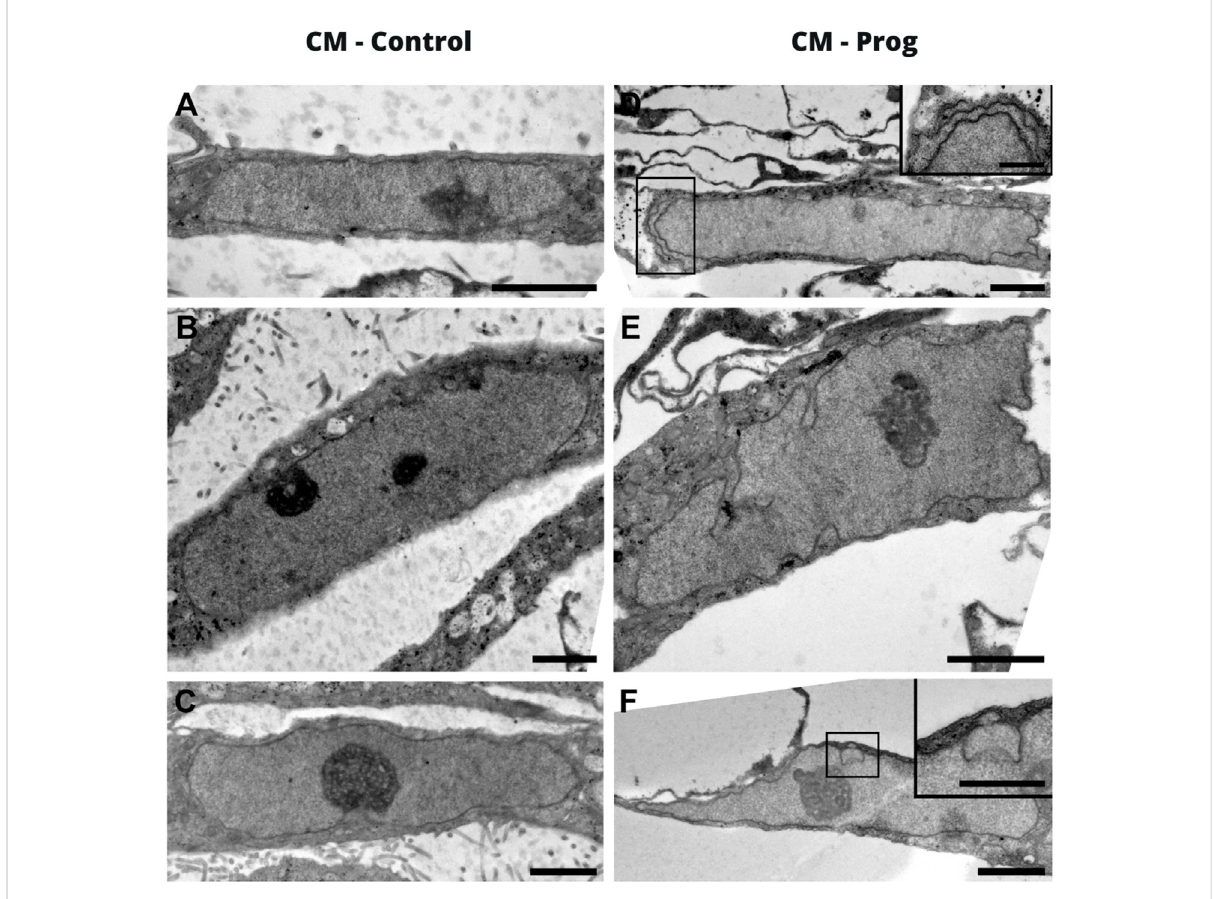
FIGURE 2 Nuclear morphology ofiPSC-derived cardiomyocytes byelectrontomography. (A – C) Images correspond totheCM-Control,and (D – F) to the CM-Prog. The scale bar on the images is 2 um and in the inserts it is 1